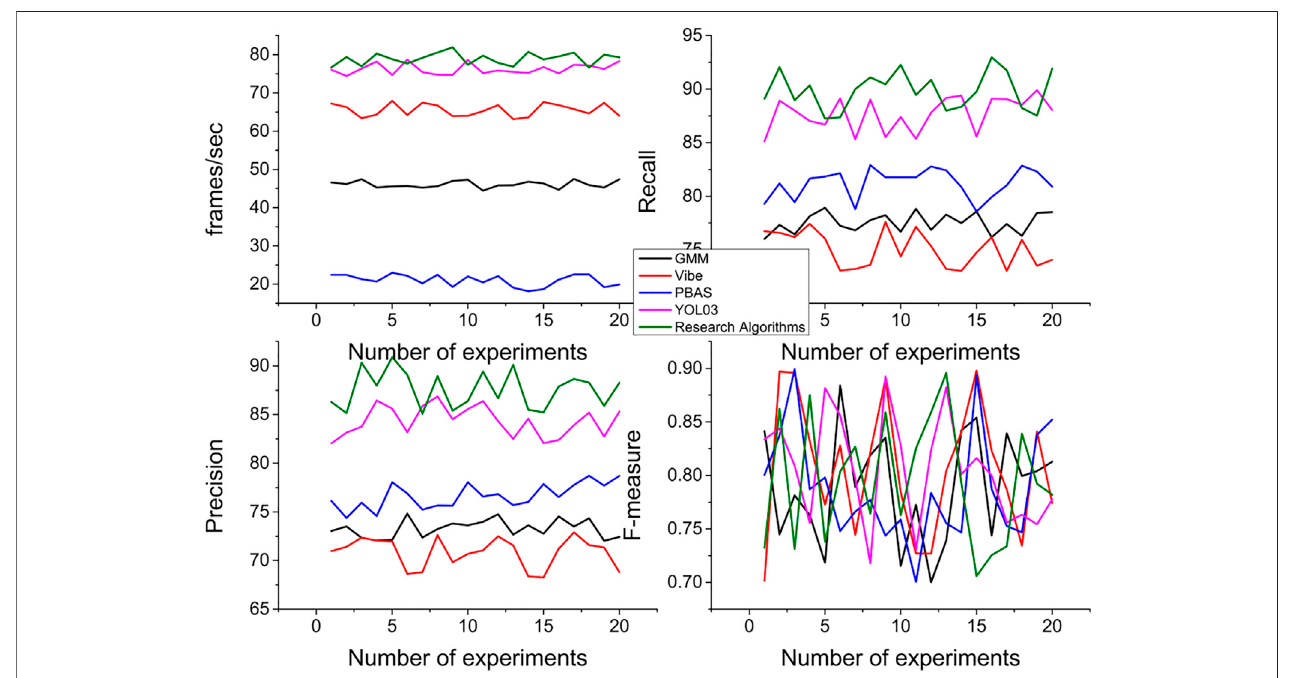
FIGURE 9 | Average performance comparison of algorithms.